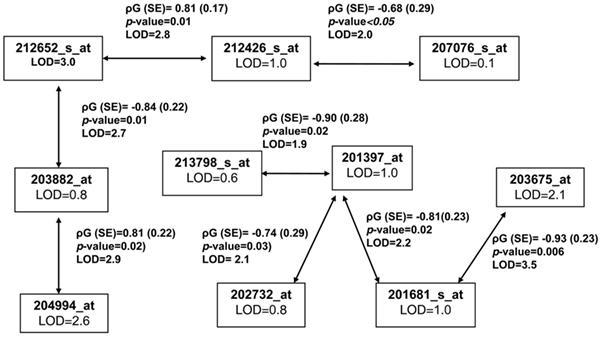
Chromosome 4 co-localized gene transcripts univariate and bivariate analyses results (n = 15 transcripts). Each box has the transcript name (in bold) and the univariate transcript LOD score. Genetic correlation (ρG) between two transcripts and p-values are displayed in the outside box along with the bivariate LOD scores. We found two potential networks of regulatory genes among 15 co-expressed transcripts on the 4q28.2 to 4q31.1 region. Five transcripts did not have significant genetic correlation with any other transcript and are not included in this graph.